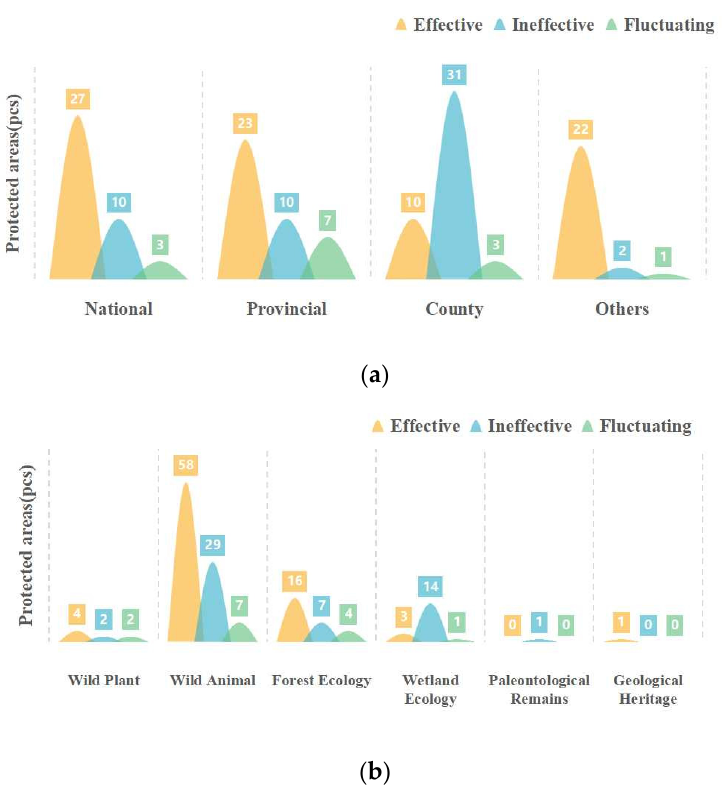
Figure 6. ( a ) Statistics by administrative level. ( b ) Statistics by type.